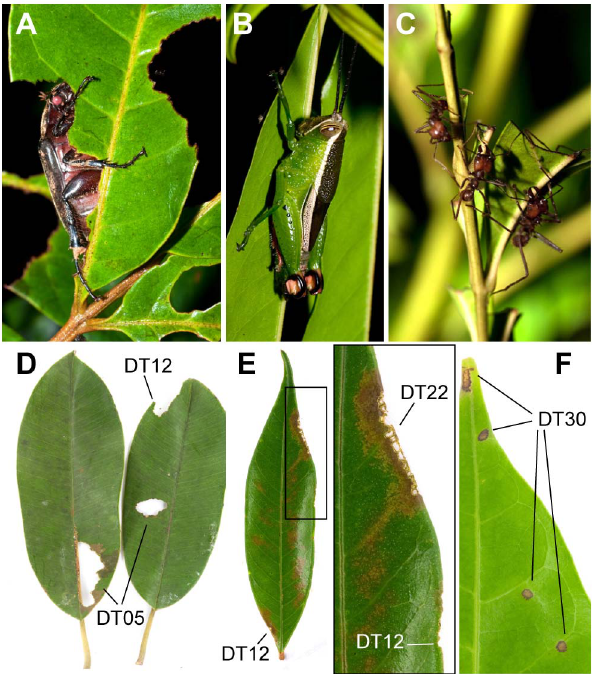
Figure 1. Selected leaf-chewing insects collected from two Panamanian forests, and induced external leaf damage resulting from insect feeding experiments. ( A ) Phyllophaga sp. 2 (Coleoptera: Scarabaeidae) observed inducing margin feeding DT12 and DT14 on Tapirira guianensis Aubl. (Anacardiaceae). ( B ) Tettigoniidae sp.4. (Orthoptera) on leaves of Guatteria dumetorum R. E. Fr (Annonaceae). ( C ) Atta sp.1 (Hymenoptera: Formicidae) on leaflets of Jacaranda copaia (Aubl.) D. Don (Bignoniaceae) causing margin feeding DT13. ( D ) Hole and margin feeding DT05, DT12 on leaves of Manilkara bidentata (A. DC.) A. Chev. (Sapotaceae) induced by Tettigoniidae sp.5 (Orthoptera). Sample 09-216. ( E ) Margin feeding DT12 and skeletoniza- tion DT22 on leaves of Vochysia ferruginea Mart. (Vochysiaceae) induced by multidamaging species Cryptocephalinae sp.1 (Coleoptera: Chry- somelidae). Sample 09-131. ( F ) Surface feeding damage DT30 on leaf of T. guianensis , inflicted by monodamaging species Homeolabus analis Illiger (Coleoptera: Attelabidae). Sample